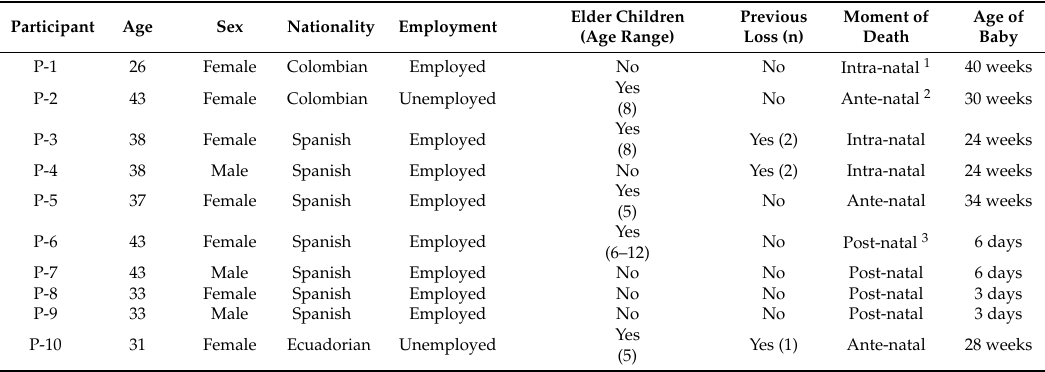
Table 1. Socio-demographic data of the participants ( N =